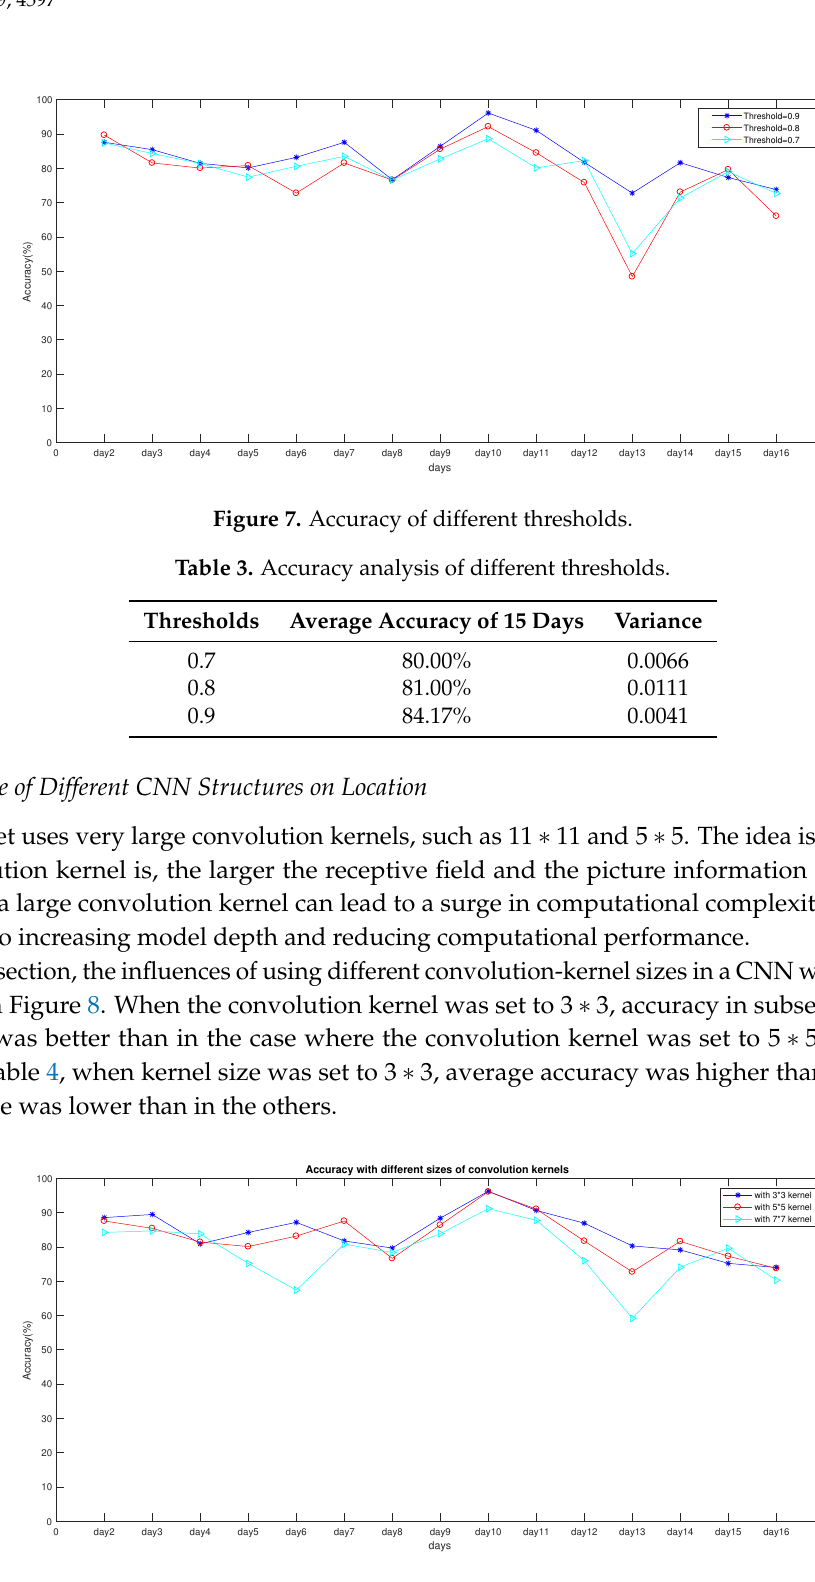
Figure 8. Impact of different thresholds on